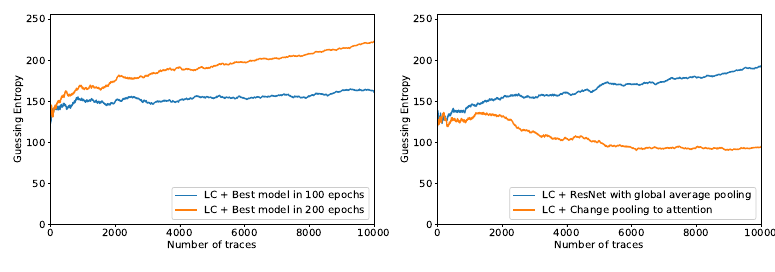
Figure 17: Guessing entropy of two state-of-the-art CNNs (with additional LC layer) applied to raw